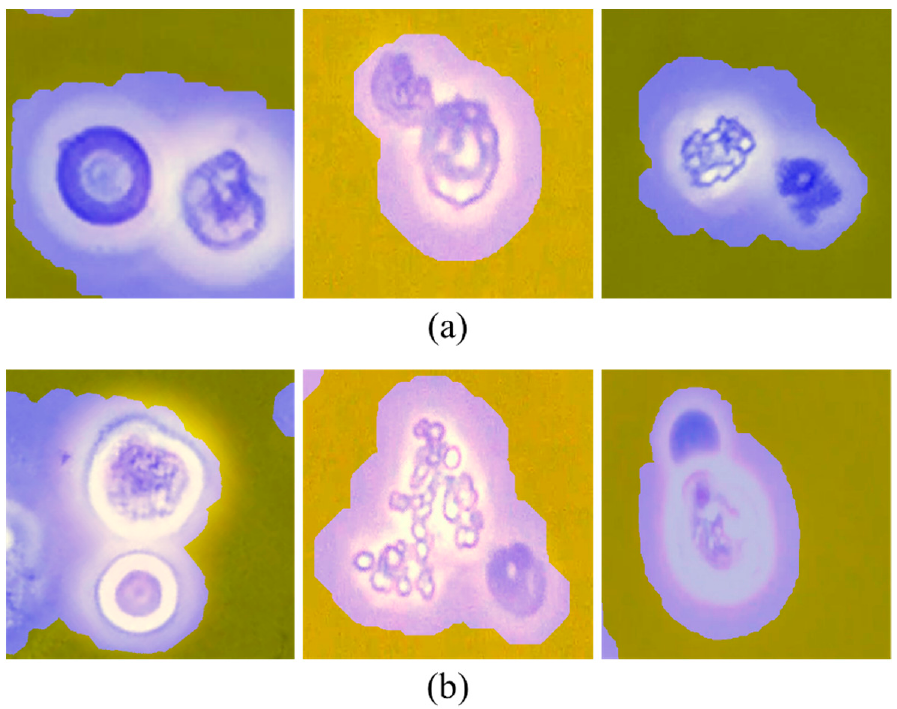
Figure 5. The purple regions are the masks of ( a ) several U-RBCs close to each other, and ( b ) U-RBCs and other urine sediments close to each other. The mosaic data enhancement method is used in Yolov4. Mosaic data enhance- ment adopts four images, which are spliced using random scaling, random clipping, and random layout. As shown in Figure 6, with the increasing number of training iterations, the loss function will gradually converge to the minimum, and the training of YOLv4 is supposed to be stopped.